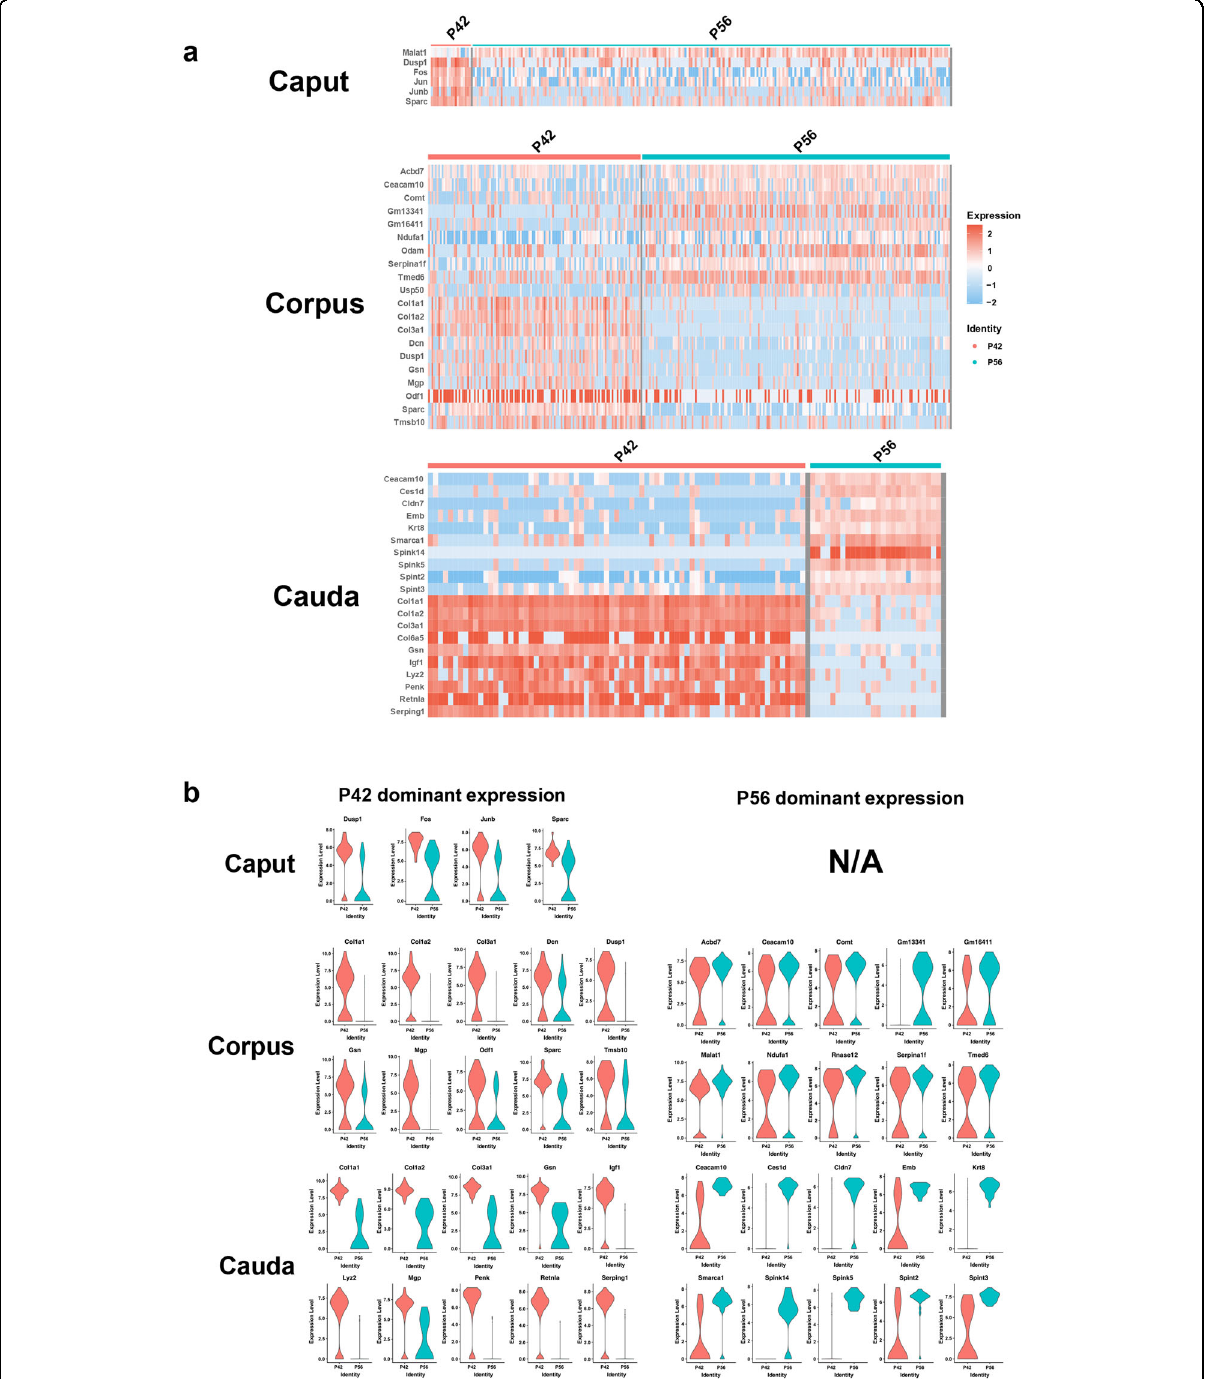
Fig. 5 Segmental DEG comparison of fi rst-wave sperm (P42) production and adult sperm (P56). a Heatmaps of DEGs for P42 and P56 spermatozoa in the caput, corpus, and cauda epididymis (log1pRPM scaled by row). b Violin plots showing segmental expression of spermatozoa DEG genes at different stages. NA: There were no representative DEGs that were highly expressed in P56 sperm compared to P42 sperm in the caput